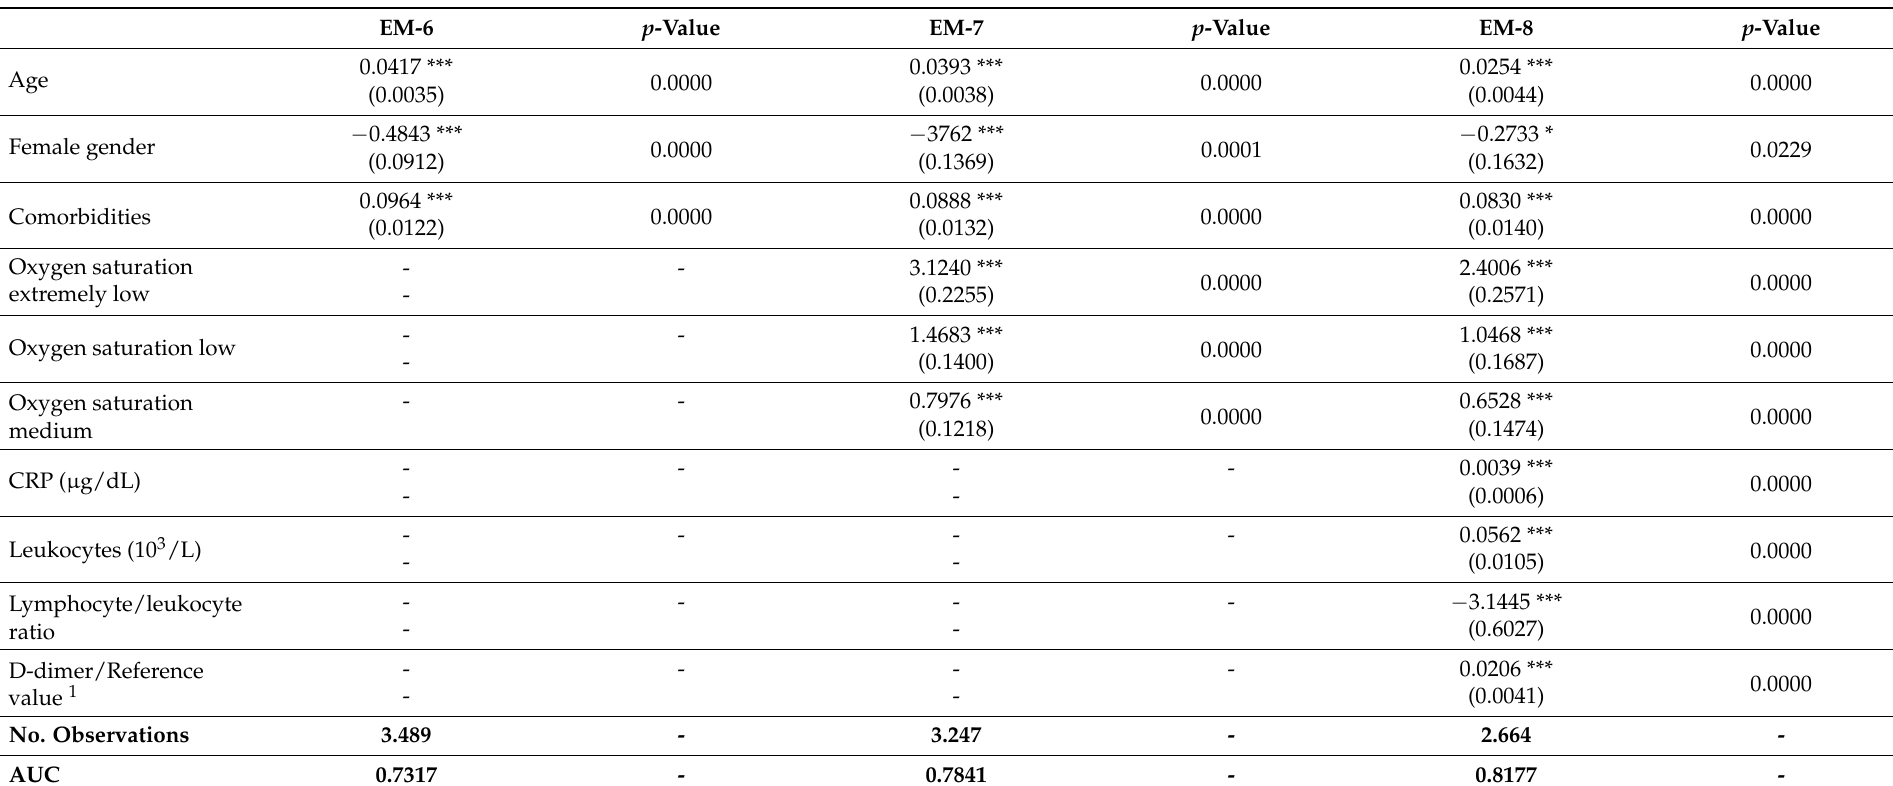
Table 6. Estimated parameters of the models in Grupo Hospitales de Madrid (CH-HM) and Hospital Universitario Pr í ncipe de Asturias (MH-HUPA) datasets with alternative specifications for